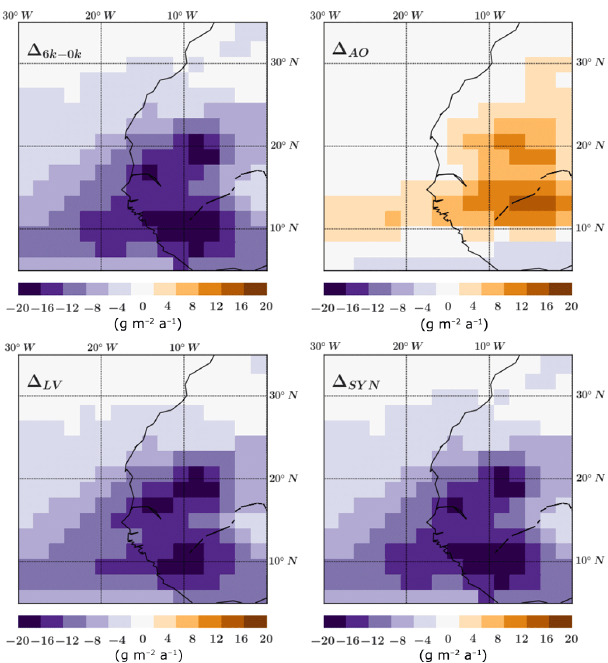
Figure 8. Differences in simulated dust deposition along the north- west African margin (30–17 ◦ W; 5–35 ◦ N) between 6 k and 0 k (cid:49) 6 k − 0 k (top left), (cid:49) AO (top right), (cid:49) LV (bottom left) and the syn- ergy effect (cid:49) SYN (bottom